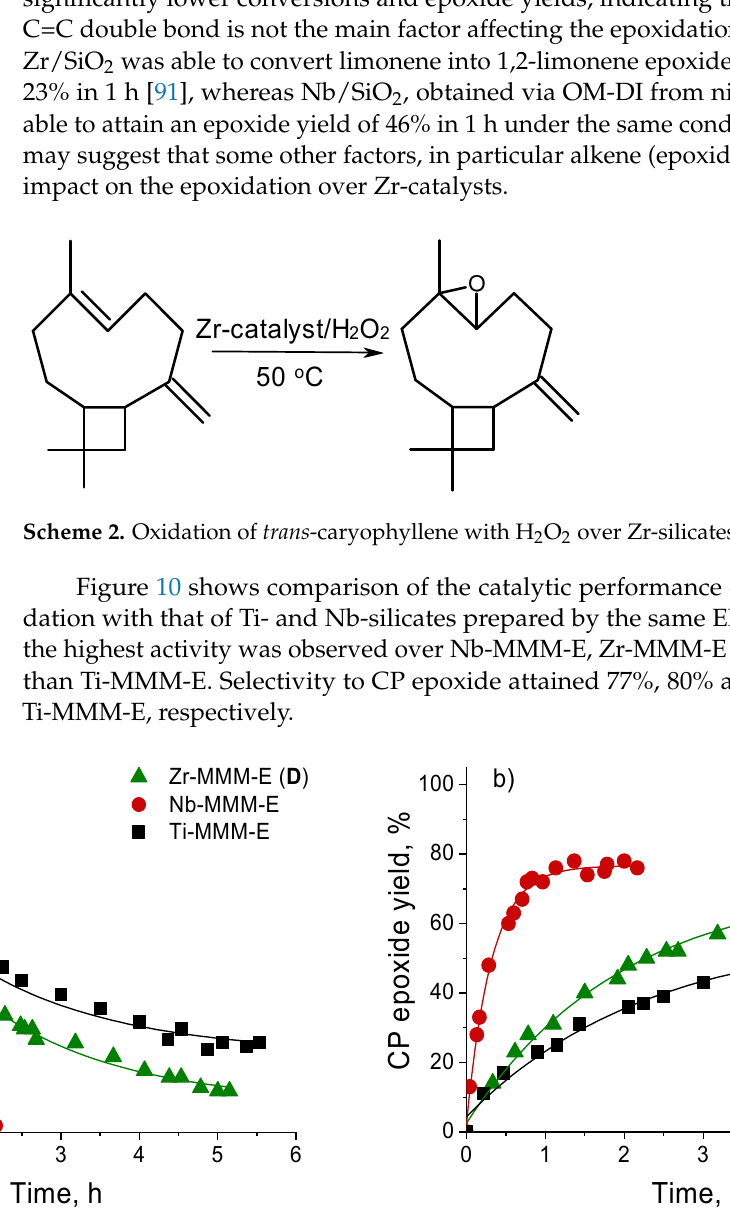
Table 4. Caryophyllene oxidation with H 2 O 2 in the presence of Zr-Si catalysts a . Catalyst